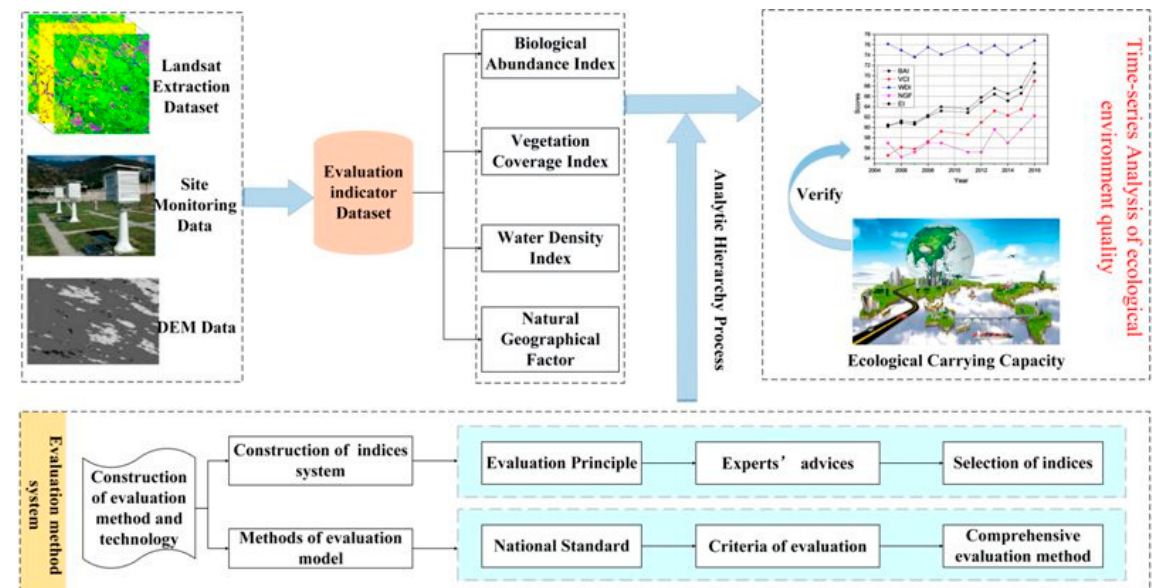
Figure 4 . Flow chart of quantitative evaluation of the ecological environment. Figure 4. Flow chart of quantitative evaluation of the ecological environment.